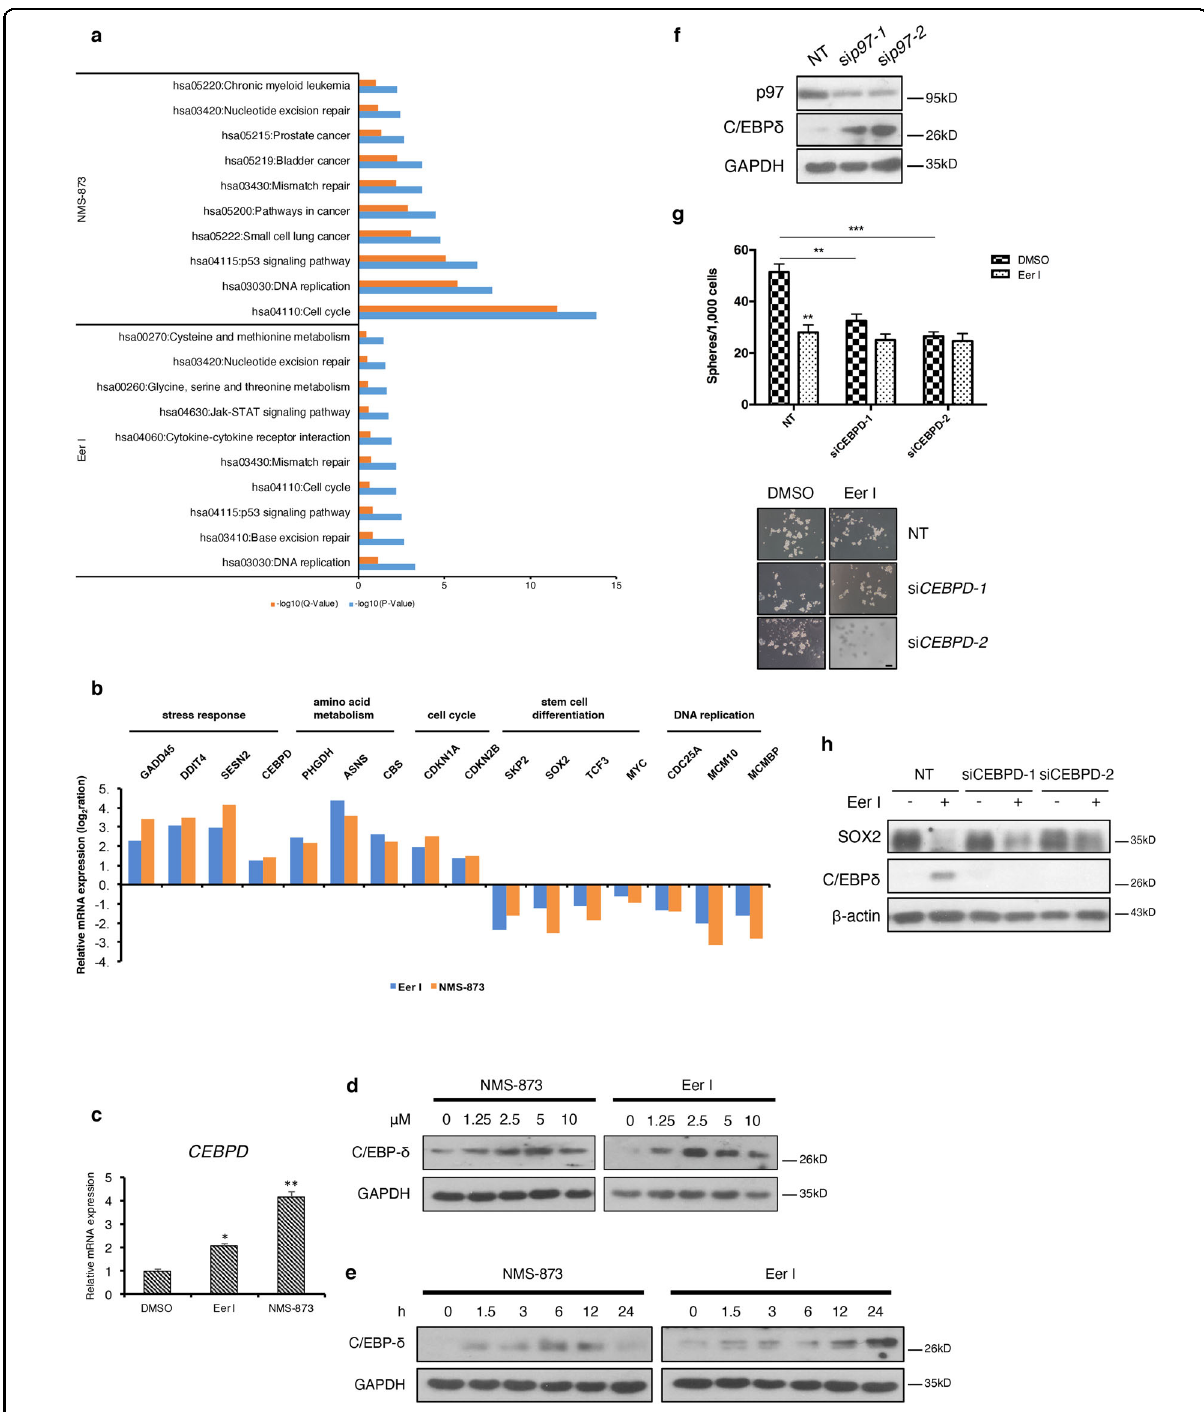
Fig. 6 Loss of p97 upregulates C/EBP δ expression. a Pathways affected by p97 inhibition in MDA-MB-231 cells. b Microarray analysis of the representative up and downregulated genes. c qPCR analysis of CEBPD mRNAs from the MDA-MB-231 cells treated with 2.5 μ M Eer I or NMS-873. d , e Immunoblotting analysis of C/EBP δ from the MDA-MB-231 cells treated with increasing concentration of Eer I or NMS-873 and the MDA-MB-231 cells treated with 2.5 μ M Eer I or NMS-873 from 1.5 to 24 h. GAPDH serves as a loading control. f Immunoblotting of C/EBP δ from the MDA-MB-231 cells with p97 silenced. GAPDH serves as a loading control. g Mammosphere formation of Eer I-treated MDA-MB-231 cells and with CEBPD silenced. Upper: the number of spheres under each treatment. Lower: representative images. Bar: 100 μ m. h Immunoblotting of C/EBP δ and SOX2 from the Eer I- treated MDA-MB-231 cells with CEBPD silenced. Data were shown as mean + SD. * P < 0.05, ** P < 0.01, and *** P <